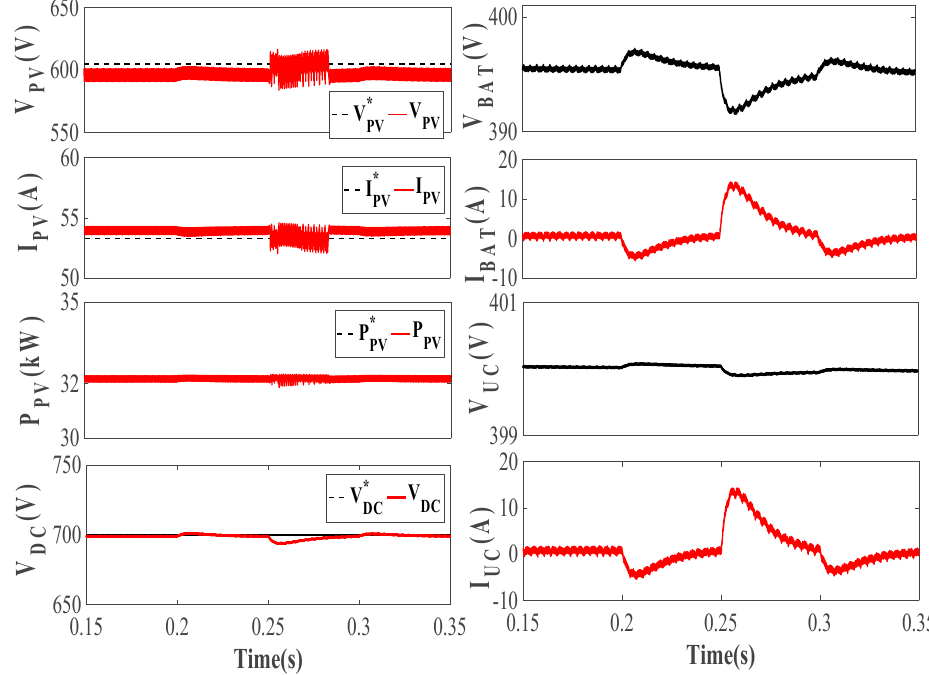
(cid:2204) , (cid:2191) (cid:2175)(cid:2183)(cid:2184)(cid:2185) (cid:2175)(cid:2183)(cid:2184)(cid:2185) Sabc , i Sabc , i La , i Ca , V d , i Sn , i Cn , i Ln , P g and Q g . Figure 10. Abnormal grid voltage analysis of